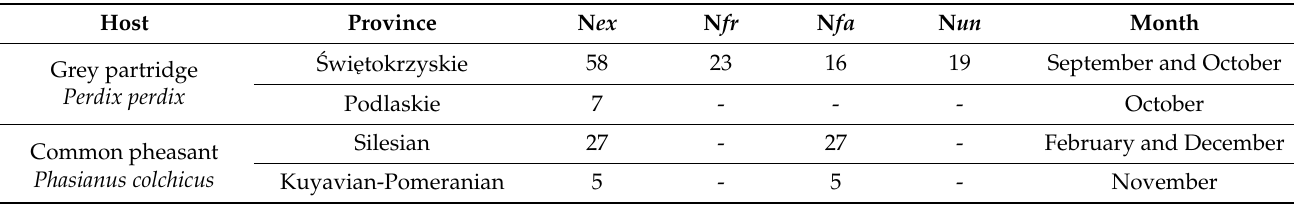
Table 1. Partridges and pheasants from the Kuyavian-Pomeranian, Podlaskie, Silesian, and ´Swi˛etokrzyskie Provinces, Poland, 2015–2017. Numbers indicate the number of game birds used in the